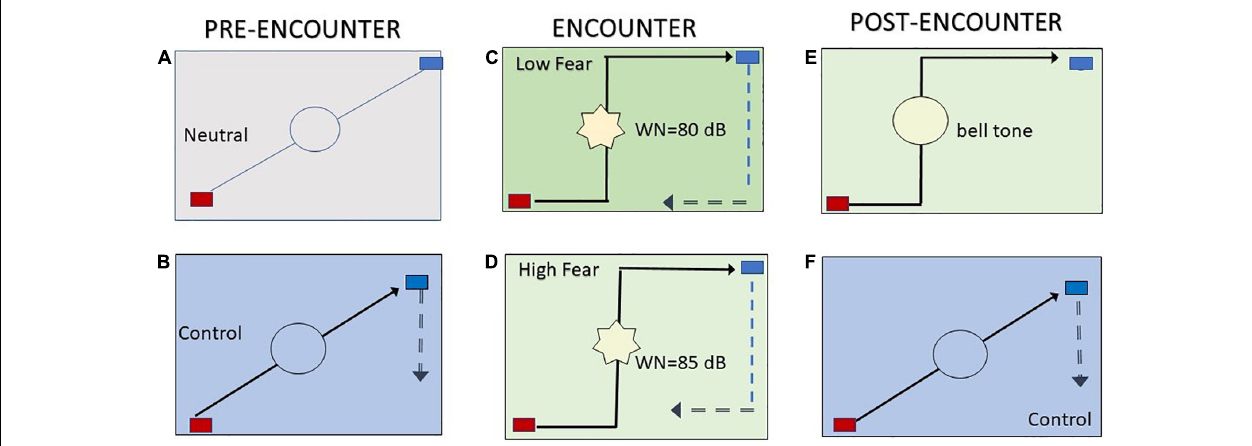
FIGURE 1 | Virtual predator and prey paradigm. Subjects were presented with a two-dimensional open field that contained a 25 cm × 20 cm rectangle. Each of the five blocks of the task began with the subject moving a blue rectangle to (i) avoid the AI predator or (ii) escape the predator by going outside the open field. The experimental condition commenced with a familiarization or neutral phase (A) , in which a preprogrammed artificial intelligence (AI) red rectangle appeared at the upper left side of the open field. The AI rectangle was presented for 60 s and programmed to wander the open field randomly and indiscriminately. During this period, the subjects could move a blue rectangle that was in the upper corner of the open field. Each time the red and blue rectangles collided (i.e., encounter or capture), a bell tone (0.5 s) was emitted. Each time the dark blue rectangle went outside the open field (i.e., escape response), a beep tone was emitted. During this period, all aspects of the paradigm were presented to the subject, who was allowed to train to manipulate the dark blue rectangle that represented the “prey” that was placed next to the predator at the upper-left side of the open field. Next, a similar phase (B) (phase 1, control) began, with the only difference that the gray background was replaced with a light blue background. Afterward, the AI neutral changed into an AI predator that pursued the prey in two phases. In phase 2 (C) , subjects received white noise (80 dB) each time the AI predator captured them (AI low predator). In phase 3 (D) , a loud white noise (85 dB) was emitted each time the predator encountered the prey (AI high predator). The change from AI neutral to AI predator was signaled by a green background in phase 2 and a light green background in phase 3. The subjects were not informed that the length of trials varied or given any indication of how much time had elapsed in each trial. Each phase was spaced by a 5 s pause that was indicated by a frozen screen. Next, the post-encounter phase (E) was like the previous phase, but the white noise was replaced with a bell tone. For comparison purposes, a control block was included at the end of the session (F) . An example of the behavioral responses in the open field during the VRP application developed by this Institute of neuroscience and Behavior (INeC) and the concomitant autonomic responses recorded by the software developed by Insight Medical Instruments is also shown in Supplementary Figure 2